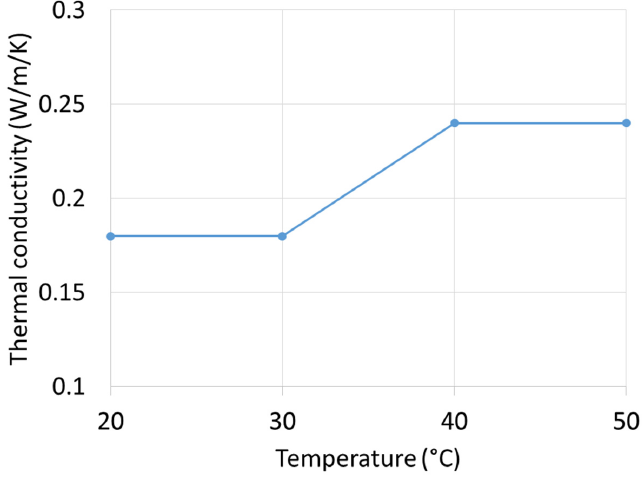
Figure 6. Thermal conductivity of PCM in the model.